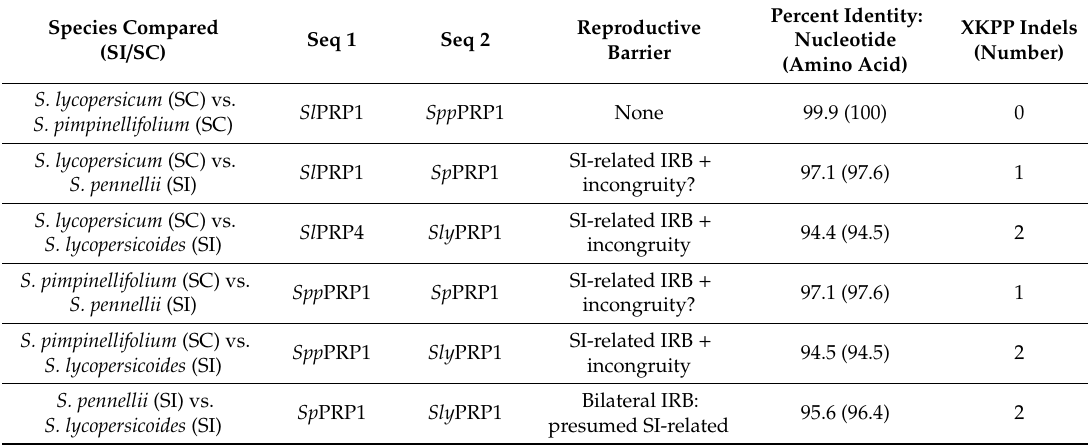
Table 6. Summary of pairwise comparisons of domains in four species of Solanum . Bilateral IRB refers to a failure to set seed in either direction, with details of the underlying mechanism not currently elucidated. A question mark denotes uncertainty or conflicting information about the breeding behavior in the current